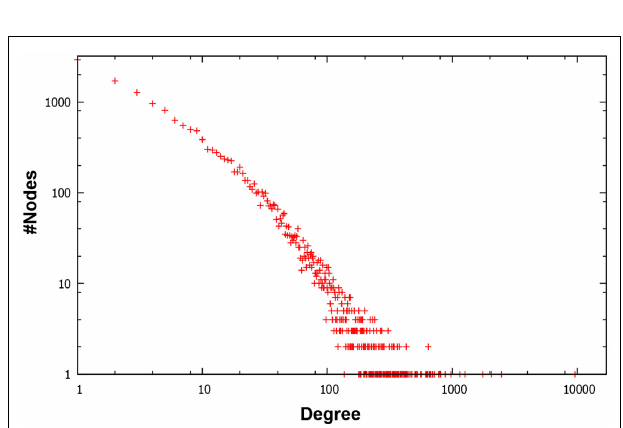
FIGURE 2 | Log–log plot of degree distribution of the final integrated PPI network in SPECTRA